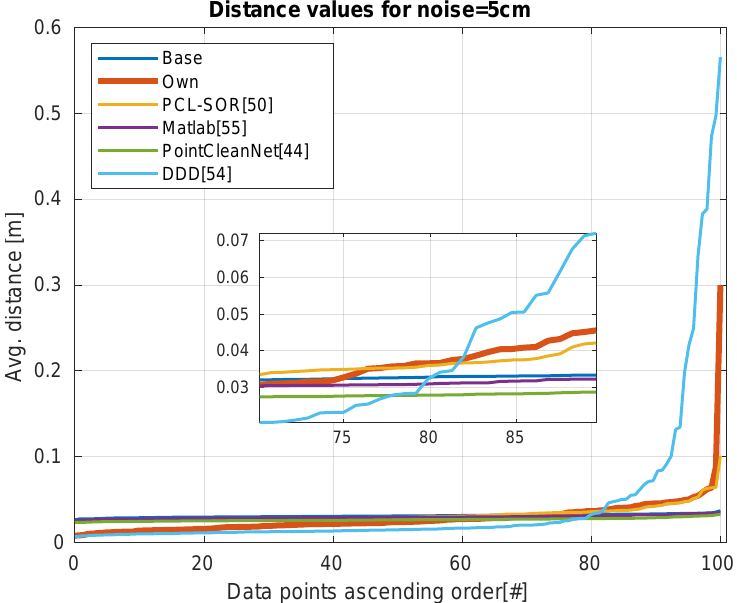
Figure 10. Noise level is 5 cm. The distribution of errors over the